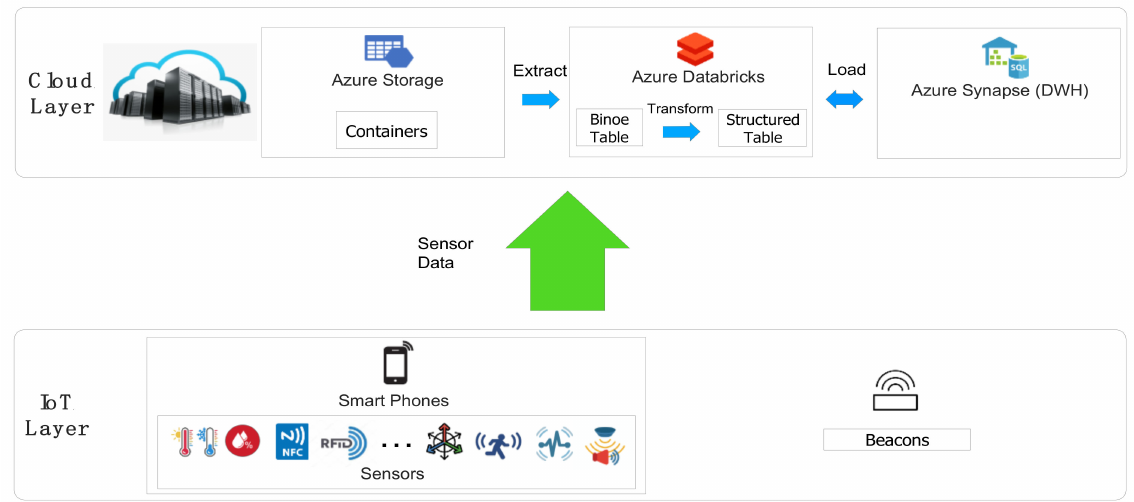
Figure 2. Current cloud-based architecture of the automatic ticketing